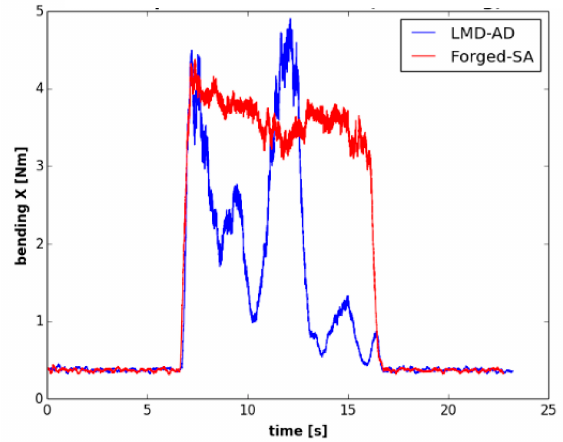
Figure 16. Bending moment evolution over time for the second set of experiments (first pass).